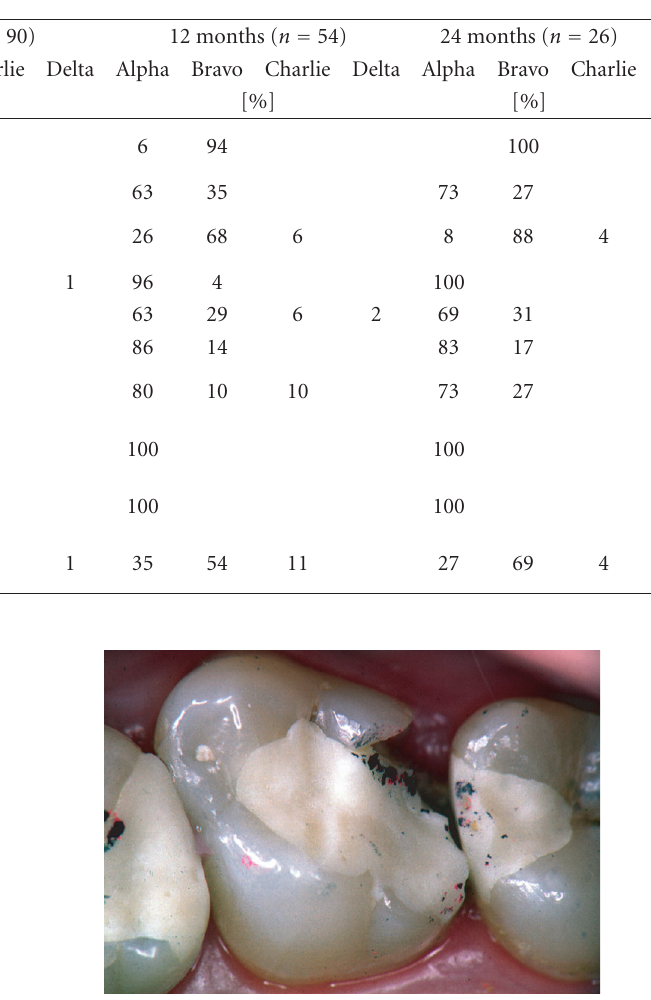
Statistical appraisal was computed with SPSS for Win- dows XP 15.0 (SPSS Inc., Chicago, IL, USA). Statistical unit